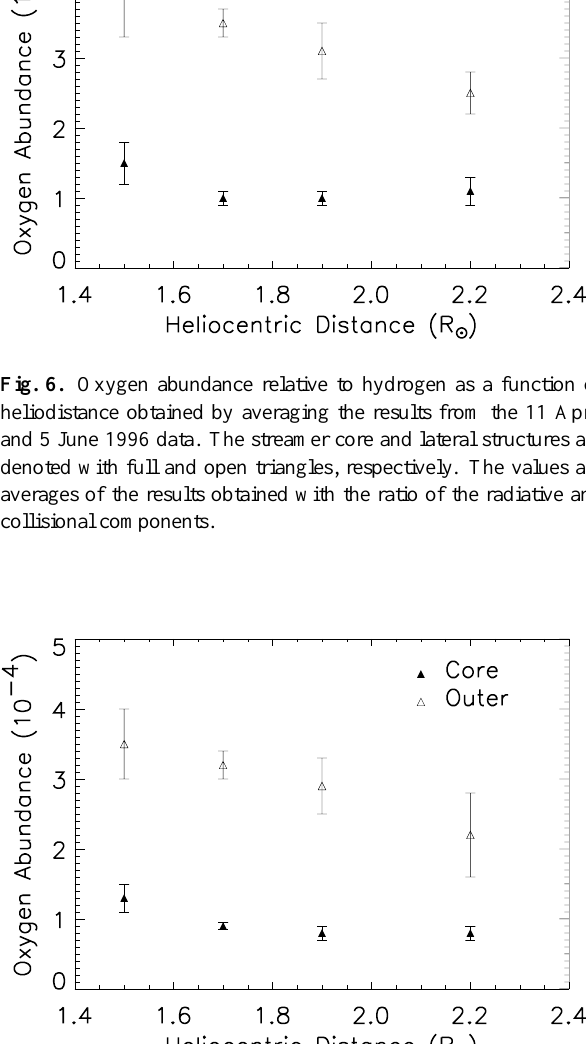
Fig. 5. Average oxygen abundance relative to hydrogen as a func- tion of heliodistance in the streamer lateral structures. Full dots and open circles indicate the values derived from the radiative and collisional components of the O VI 1032 and the H I Ly β lines, re- spectively.